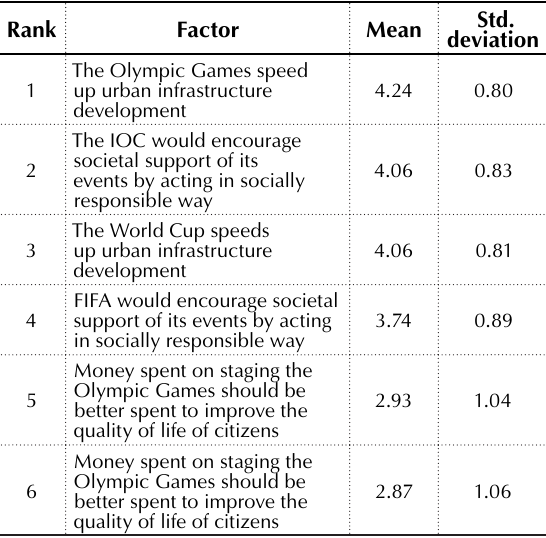
Table 3. Mean and standard deviations of a 5-point scale items